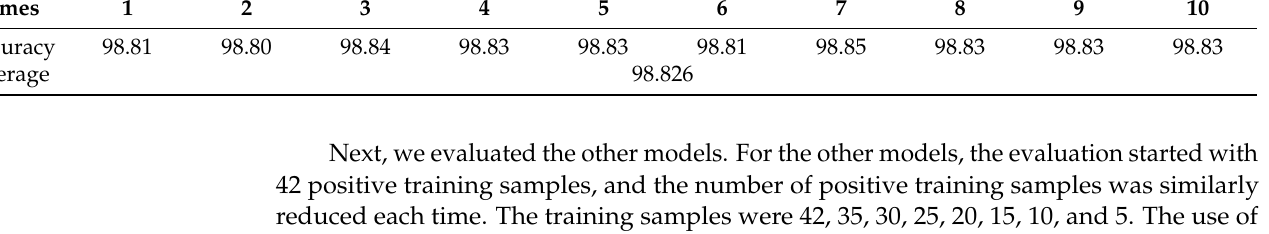
Figure 10. Ten-fold cross-validation.